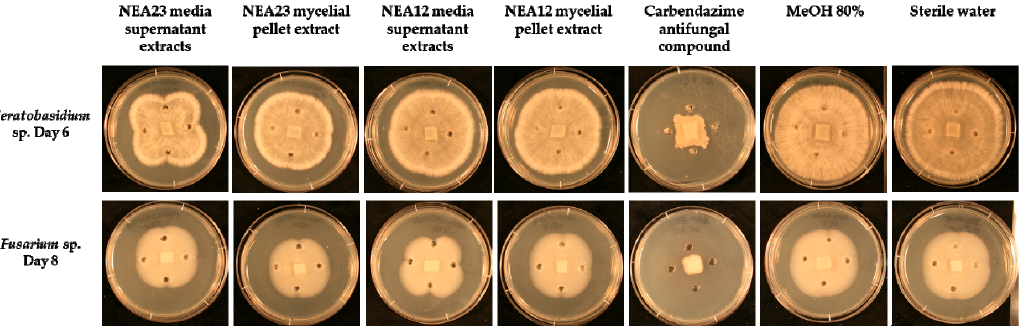
Figure 3. Agar-well diffusion assay for pathogens Ceratobasidium sp. (top panel) and Fusarium sp. (bottom panel) in the presence of (from left to right): NEA23 MS ( n = 5); NEA23 MP ( n = 5); NEA12 MS ( n = 5); NEA12 MP ( n = 5); antifungal compound carbendazim (1 mg/mL) ( n = 5); 80% methanol ( n = 5); and water ( n = 5). The images are of a typical representative of the five replicates. Refer to Figures S5 and S6 for full time